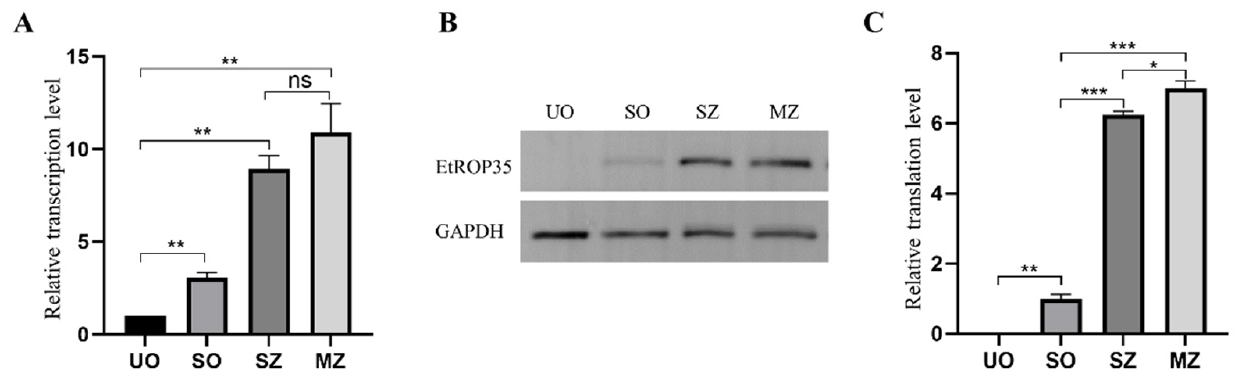
Figure 3. Expression levels of EtROP35 during multiple developmental stages of E. tenella . ( A ) Transcription levels of EtROP35. ( B ) Analysis of EtROP35 by Western blot using GAPDH as the reference. ( C ) Translation levels of EtROP35 are quantified from the Western blot bands by ImageJ 1.8.0 software (National Institutes of Health, Bethesda, MD, USA). Unsporulated oocysts (UO), sporulated oocysts (SO), sporozoites (SZ), merozoites (MZ). No obvious difference (ns): p > 0.05; significant difference: * p < 0.05, ** p < 0.01, *** p < 0.001. (Full Western Bolt is in